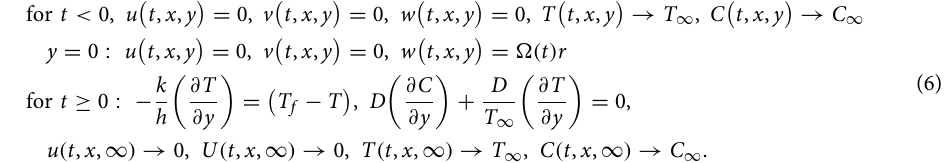
Similarity variables. To renovate above expressions which represent the flow problem to dimensionless system, we use the following similarity transformation 30